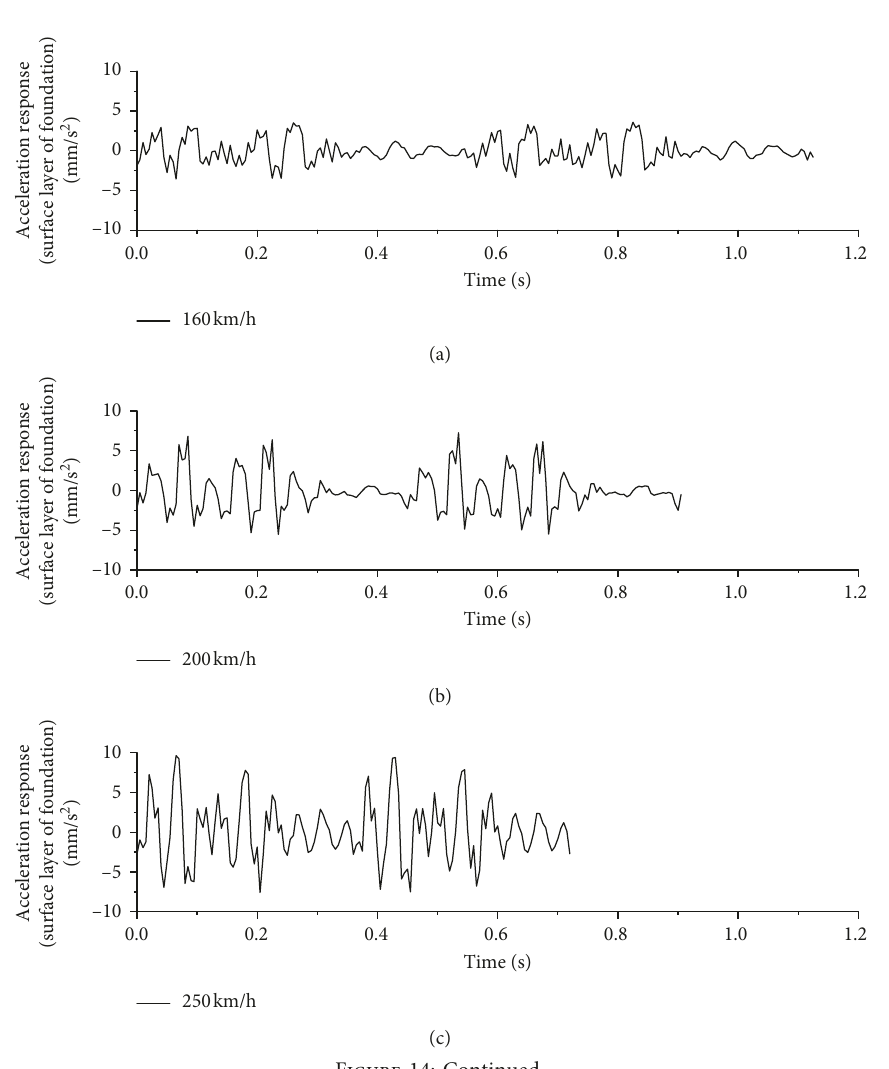
Figure 13: Spectral curve of acceleration at different locations: (a) track slab; (b) surface layer of subgrade; (c) bottom layer of subgrade; (d) surface layer of foundation.